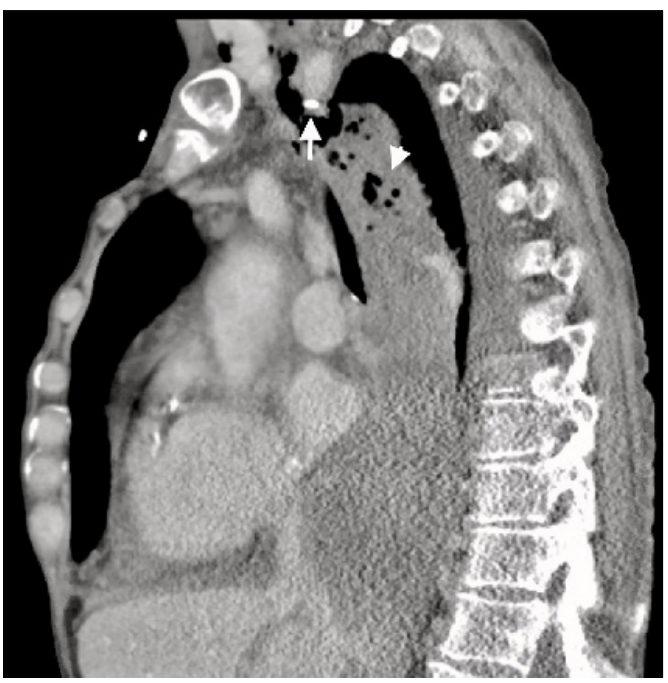
Image 2. Sagittal computed tomography of the thorax demonstrating gas and fluid collections in posterior mediastinum (arrowhead) with peripherally inserted central catheter tip (arrow) terminating extraluminal in superior